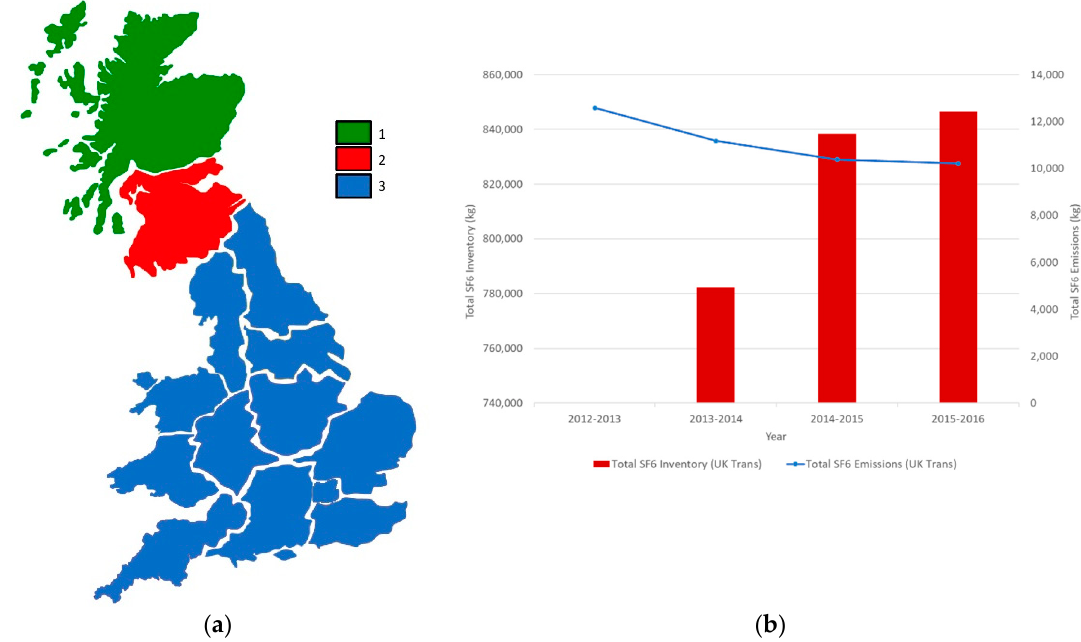
Figure 3. ( a ) Transmission network areas in Great Britain; and ( b ) total SF 6 inventory (kg) and emissions level (kg) of the electricity transmission network in Great Britain.